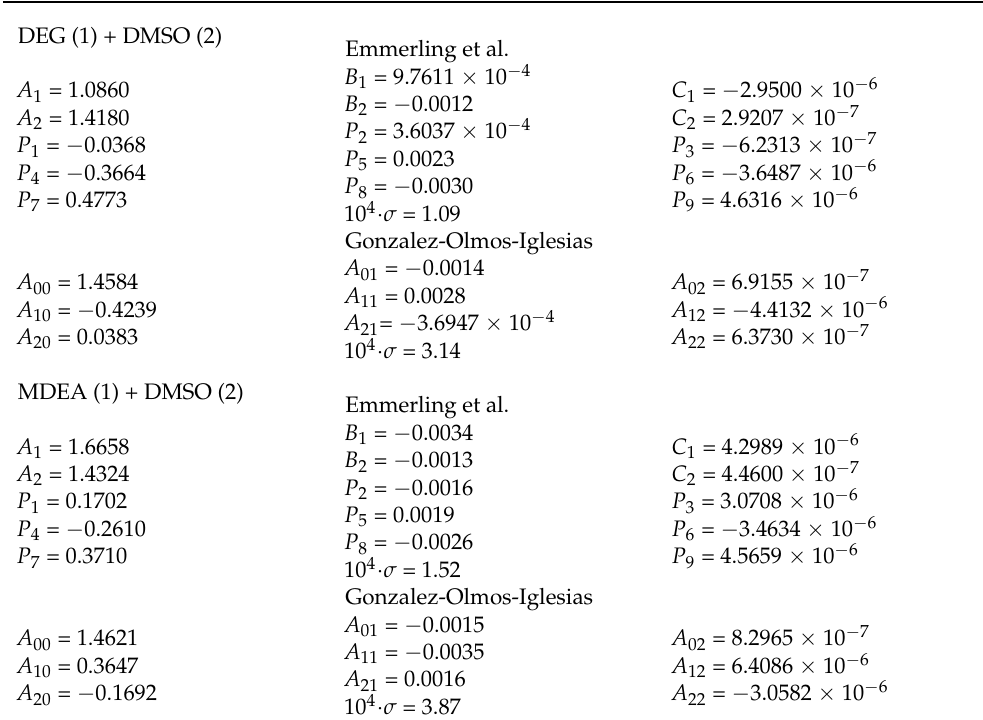
Table A2. Values of parameters in the range 293.15–313.15 K for the Emmerling et al. and Gonzales- Olmos-Iglesias models and standard deviations 1